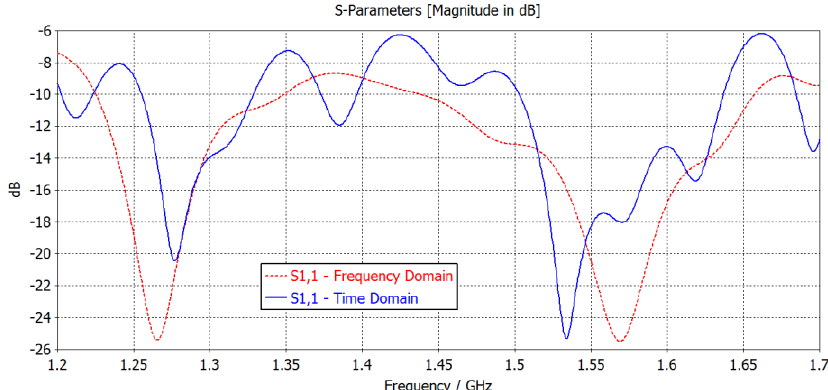
Figure 14. Design 2–16-element patch array: simulated reflection Figure 14. Design 2 – 16-element patch array: simulated reflection coefficient.